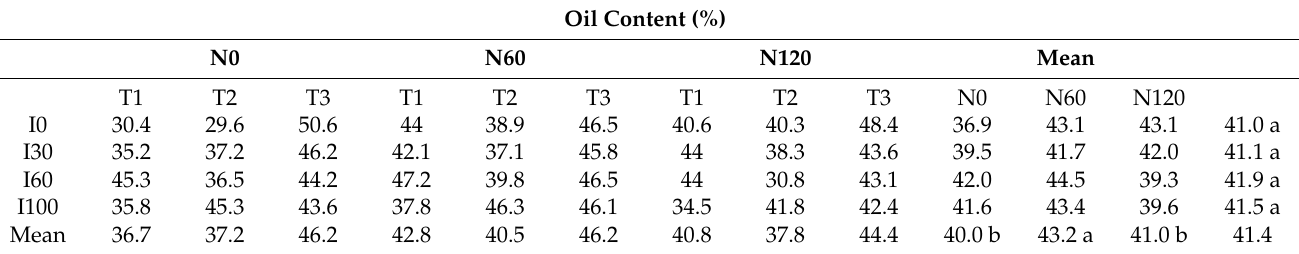
Table 4. Oil content (%) in seeds of the primary and secondary racemes in relation to irrigation (I0, I30, I60, and I00 = 0, 30, 60, and 100% ETm, respectively) and N level (N0, N60, and N120 = 0, 60, and 120 kg ha − 1 N) of primary and secondary racemes in 2021 and secondary racemes in 2022 (T1, T2, and T3). In the mean columns, the average values of all N levels (last row) and the average values of all irrigation levels (last column) followed by the same letter did not significantly differ at p ≤ 0.05. Oil Content